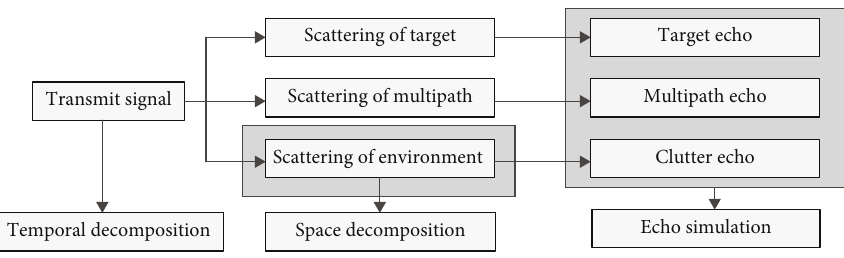
Figure 9: Diagram of the echo signal modeling process.